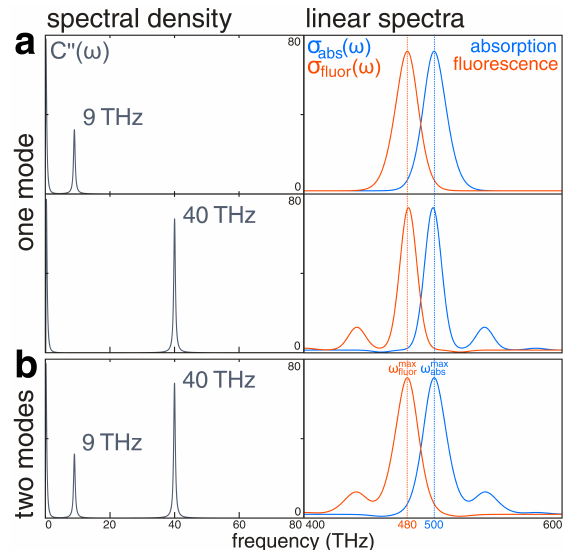
Figure 2. Spectral density, C (cid:48)(cid:48) ( ω ) (left panels), and linear spectra from absorption and fluorescence lineshapes, σ abs ( ω ) and σ fluor ( ω ) (right panels), calculated with ( a ) one mode with frequency ω 0 = 9 THz or 40 THz and ( b ) two modes with frequencies ω 0 = 9 THz + 40 THz. In the linear spectra, the frequency of maximum absorption ( ω max ) and the frequency of maximum fluorescence abs ( ω max ) are fluor